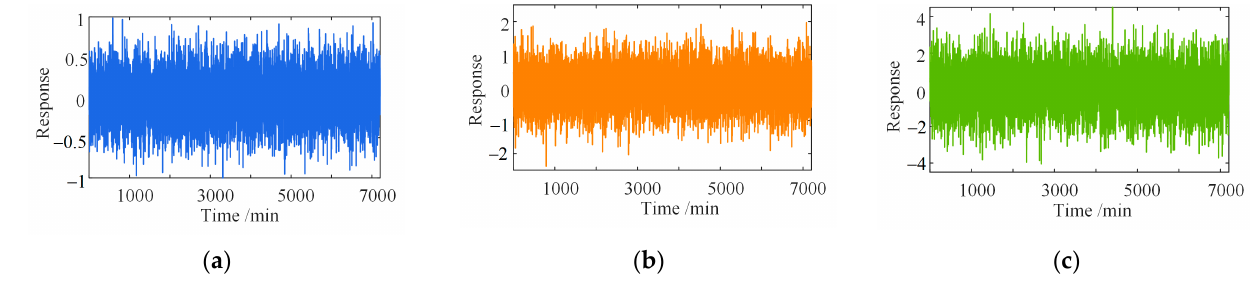
Figure 11. Different degrees of noise (five days): ( a ) e p = 5%; ( b ) e p = 10%; ( c ) e p = 20%.